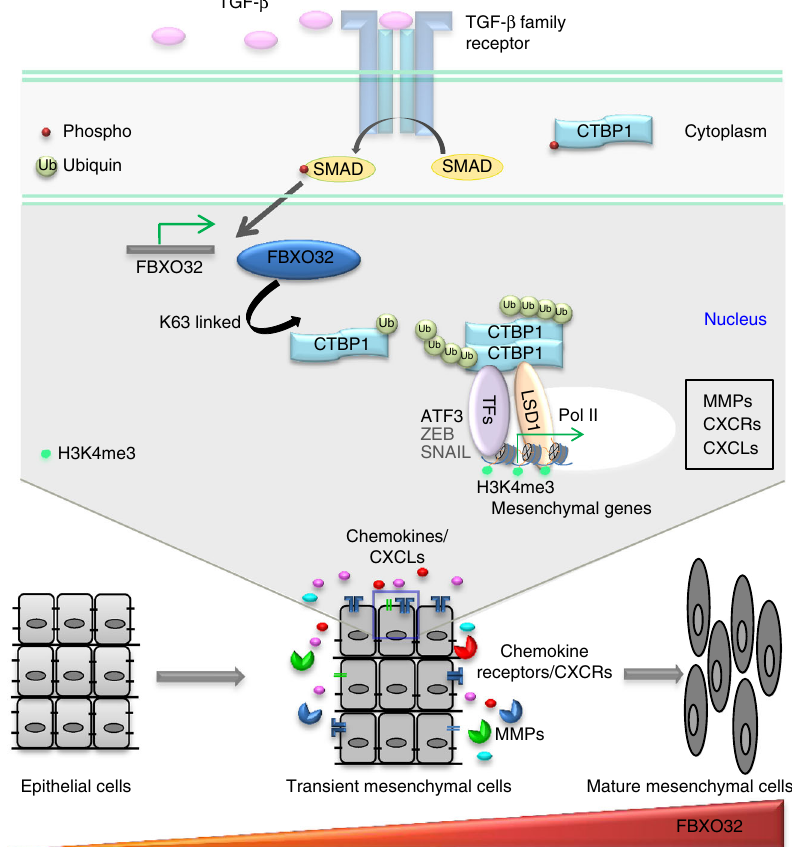
Fig. 8 FBXO32 acts as a master regulator of EMT by governing the gene expression program underlying this process. The model showing roles of FBXO32 during EMT. The onset of EMT crucially relies on SMAD-mediated transcriptional changes, and FBXO32 is one of the ubiquitin ligases upregulated during this process. FBXO32-mediated-K63 ubiquitination of CtBP1 leads to the nuclear retention of CtBP1 and so it can be recruited by various transcription factors like ATF3 to assist in chromatin remodeling. This leads to alterations in the transcription of key EMT and migration promoting genes, such as